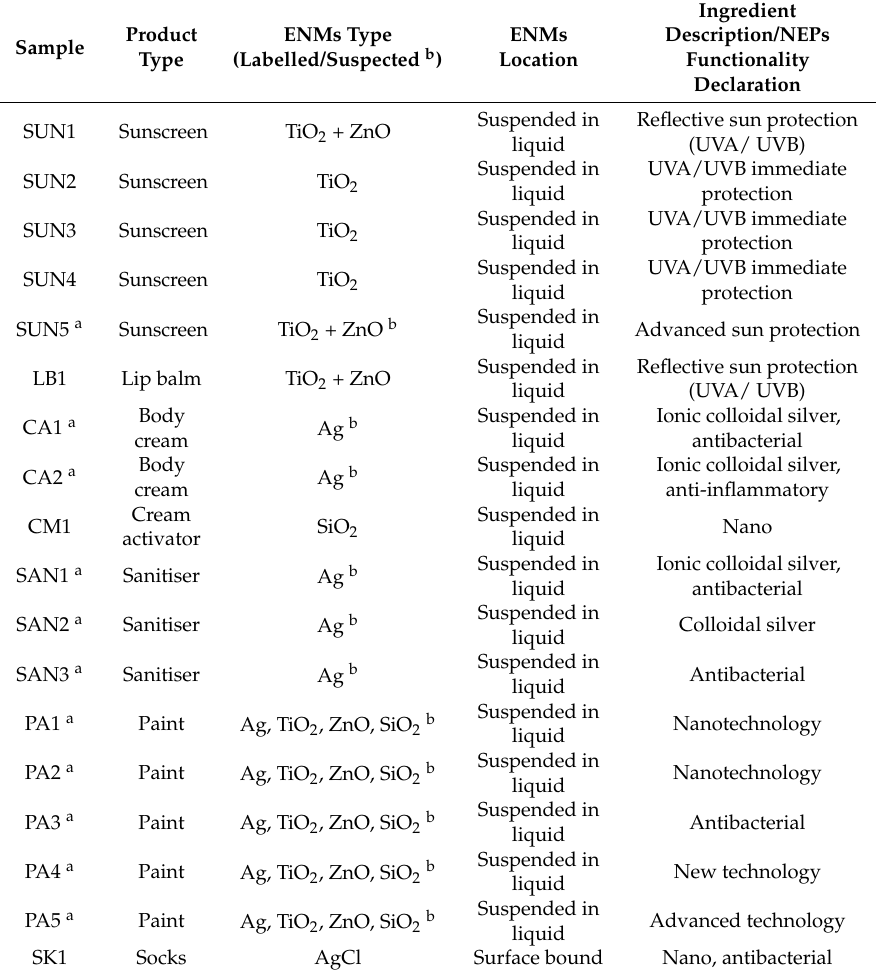
Table 1. The sample of nano-enabled products (NEPs) examined. a and b respectively indicate suspect products and engineered nanomaterials